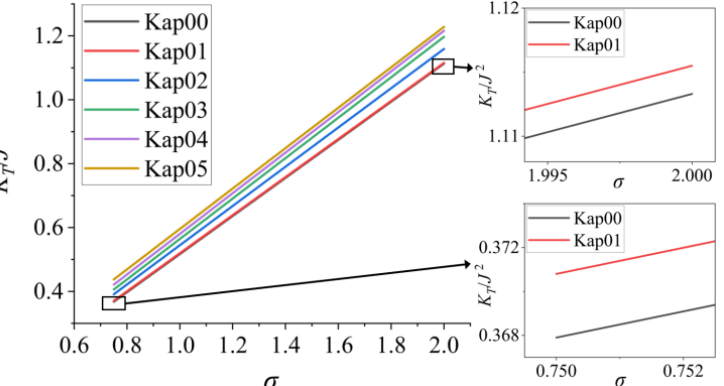
Figure 20. Relationship of cavitation number and thrust load factor ( J = 0.5 and 0.7, and 30 rps).